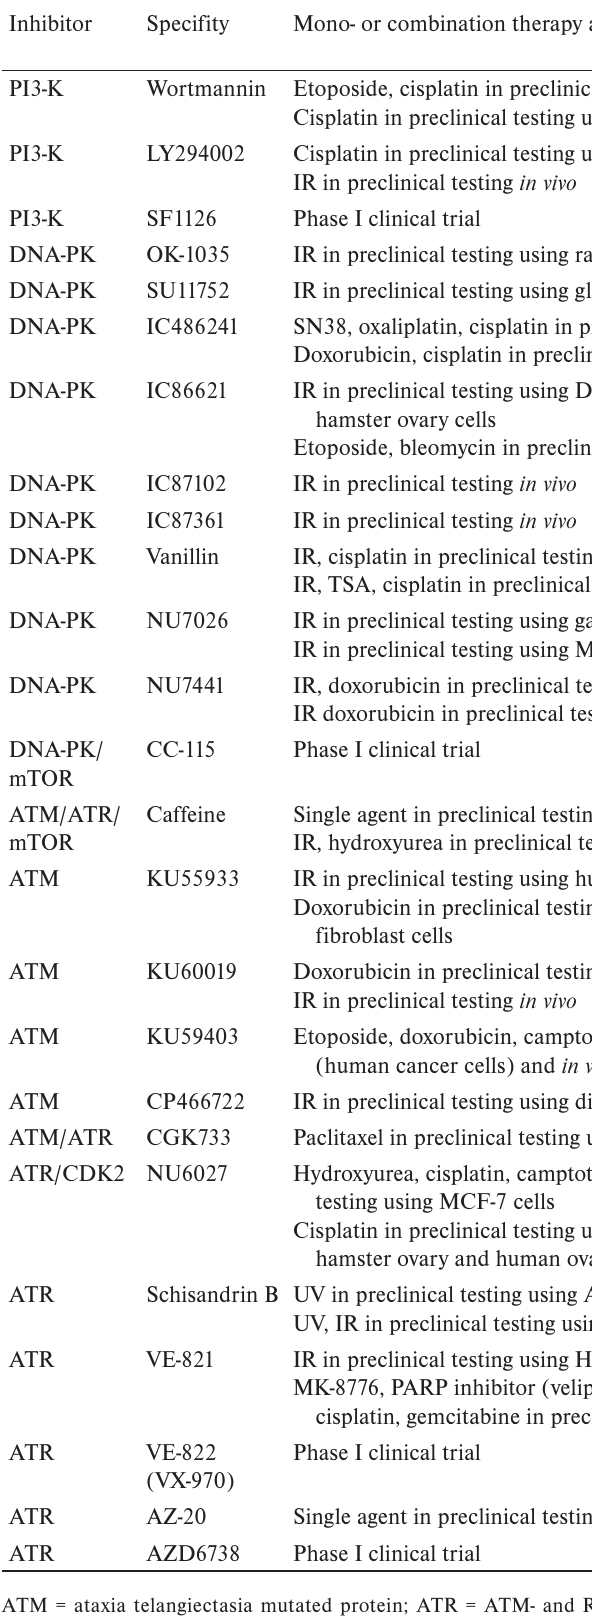
ATM = ataxia telangiectasia mutated protein; ATR = ATM- and Rad3-related protein; CDK2 = cyclin dependent kinase 2; DNA-PK = DNA-dependent protein kinase; DNA-PKCS = DNA-dependent protein kinase catalytic subunit; HBV = hepatitis B virus; IR = ionising radia- tion; mTOR = mammalian target of rapamycin; PI3-K = phosphatydilinositol-3-kinases; TSA = trichostatin A; UV = ultraviolet light ; XRCC1 = X-ray repair cross-complementing protein 1. Where no reference is given, information may be found on the ClinicalTrials.gov